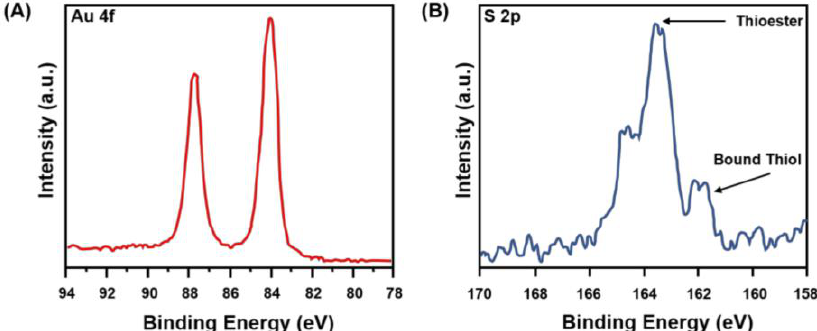
Figure 23. Au 4f ( A ) and S 2p ( B ) regions of the XPS spectra of HS-PEG2000-functionalized gold nanoshells [142].